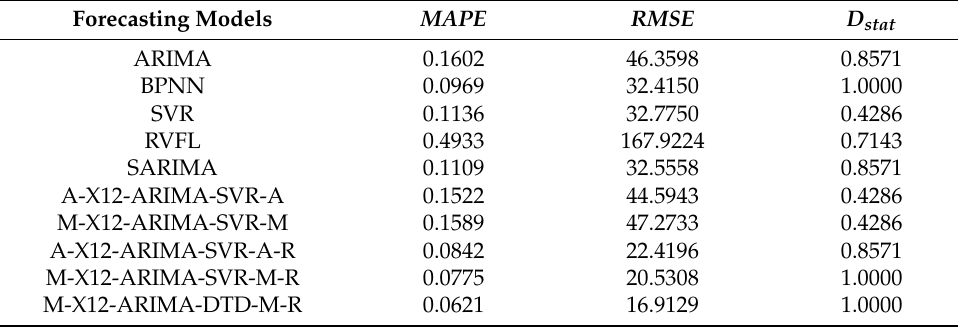
Table 14. Performance comparison of different models in